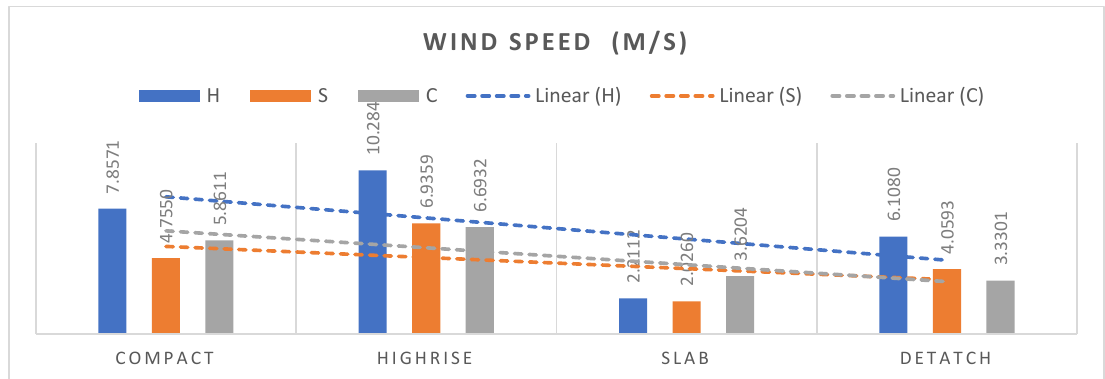
Fig. 15: Comparison of average wind speed from simulation performed on the hottest, coldest and sultriest days of the year between four selected morphotypes